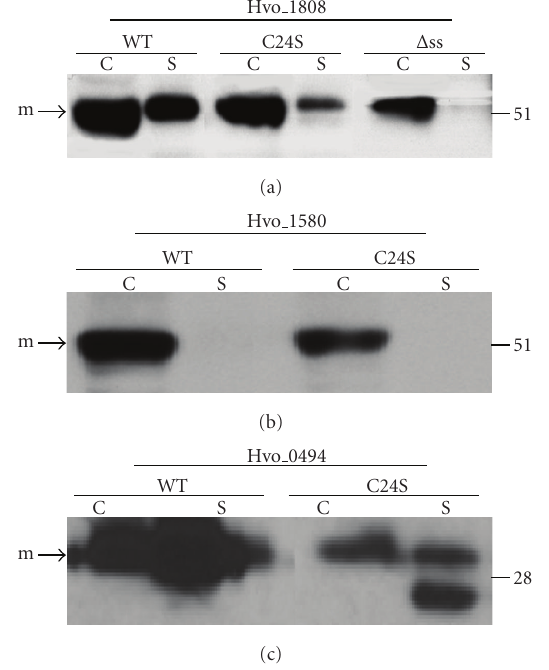
Figure 4: Cysteine to serine mutants of Hvo 1808, Hvo 1580, and Hvo 0494 are less stable than wild-type constructs but appear to be processed. Western blot analyses of wild-type proteins (WT), cysteine to serine replacement mutants (Hvo 1808C19S, Hvo 1580C24S and Hvo 0494C20S), and signal sequence deletion mutants ( (cid:2) ss) of Hvo 1808. All proteins expressed had C-terminal Myc-tags except for Hvo 0494 and Hvo 0494C20S, which were C- terminally His-tagged. Myc and His-tagged proteins were detected using anti-Myc and anti-His antibodies, respectively. Comparable amounts of protein were loaded in each lane. The migration of molecular weight standards is indicated on the right. Predicted positions of precursor (p) and mature (m) proteins are